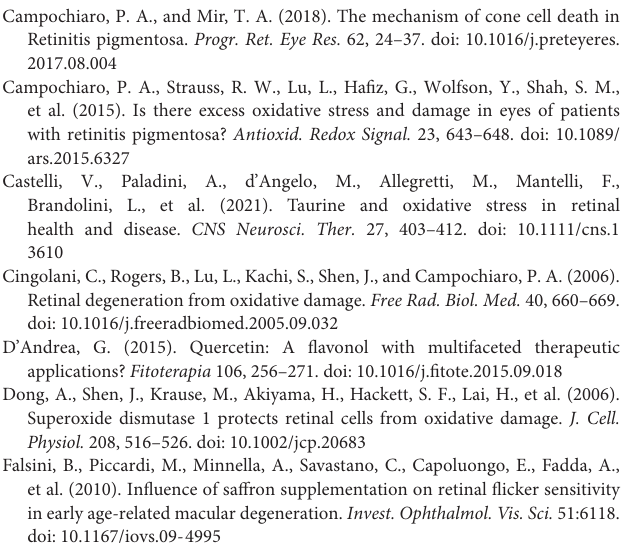
Supplementary Figure 1 | Retinal function and morphology. (A) Scotopic a- and b-wave amplitude and photopic b-wave amplitude as a function of light stimulus intensity, in Unexposed/untreated health control (black scale line) and Exposed groups (red line). (B) Representative ERG traces of scotopic and photopic ERG at the highest light intensity (377 cd ∗ s/m 2 gray bars); (C) Whole-mount retina stained against cone–arrestin protein. Supplementary Figure 2 | Specificity control of cone-arrestin antibody on retinal sections of unstressed/untreated Tvrm4 mice. Supplementary Figure 3 | Control of the specificity of RHO (A) and cone–opsin (B) antibodies, respectively, on retinal protein lysates and on cell lysates of ARPE-19, a retinal pigment epithelium cell line that physiologically does not express photoreceptor-specific